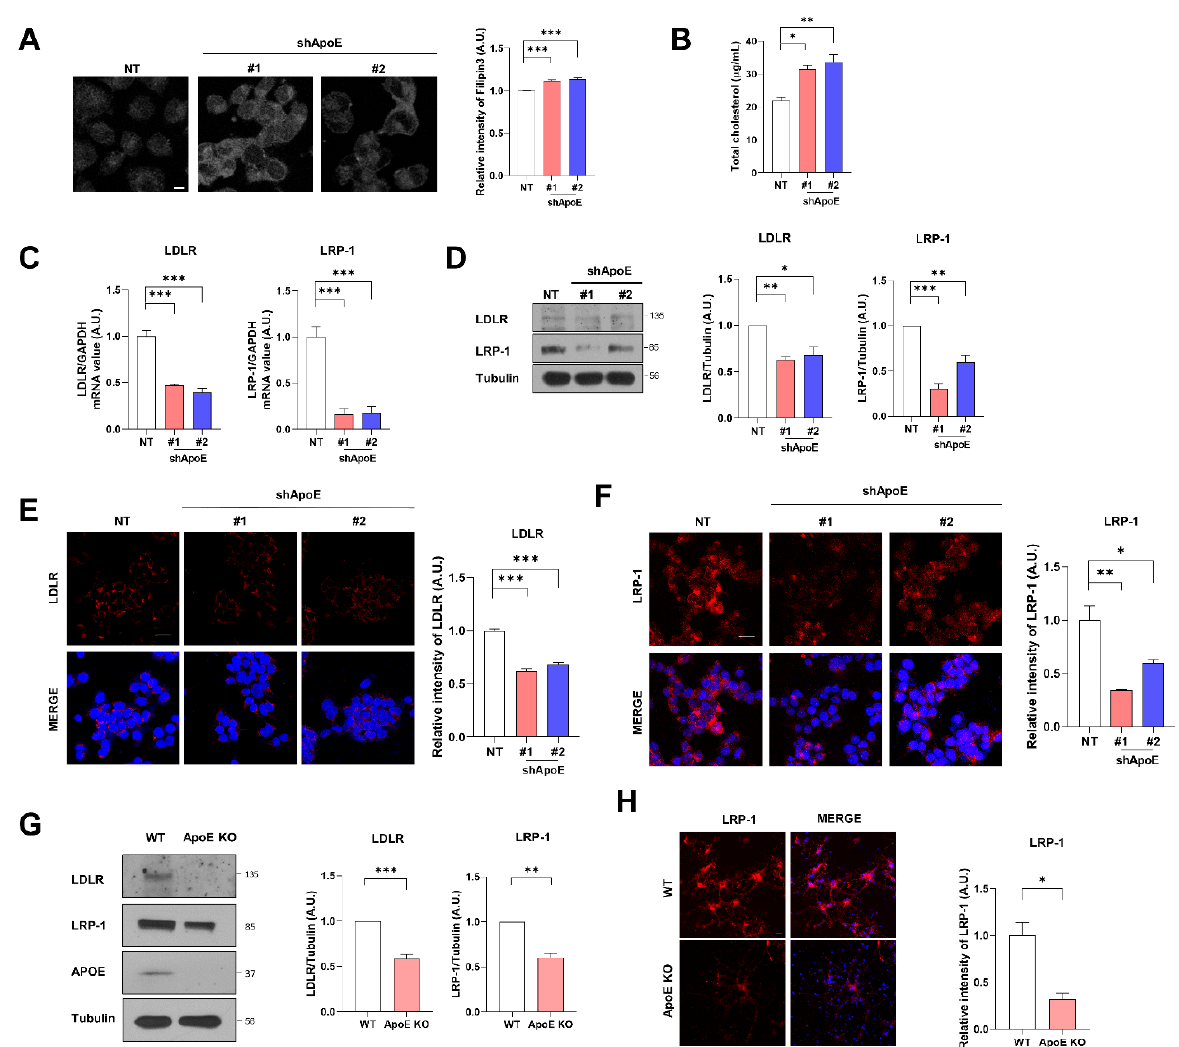
Figure 2. ApoE deficiency increases intracellular cholesterol levels and decreases the expression of ApoE receptors in neurons. ( A ) The cells were fixed and stained with filipin3. Values were derived from three independent experiments ( n = 3). ( B ) Total cholesterol levels were measured with a cholesterol assay kit. Values were derived from three independent experiments ( n = 3). ( C – F ) LDLR and LRP-1 levels were measured with RT-PCR ( C ), Western blot ( D ), and immunostaining with anti- LDLR (E) and anti-LRP-1 ( F ) antibodies. Values were derived from three independent experiments ( n = 3). ( G ) Primary neurons from WT and ApoE KO mice were lysed with RIPA buffer, and then the samples were analyzed by Western blot. Values were derived from three independent experiments ( n = 3). ( H ) Primary neurons from WT and ApoE KO mice were fixed and immunostained with anti-LRP-1. Values were derived from three independent experiments ( n = 3). * p < 0.05, ** p < 0.01, *** p < 0.001 against control; one-way ANOVA or unpaired t-tests. Blue indicates DAPI staining. Scale bars indicate 20 μ m.